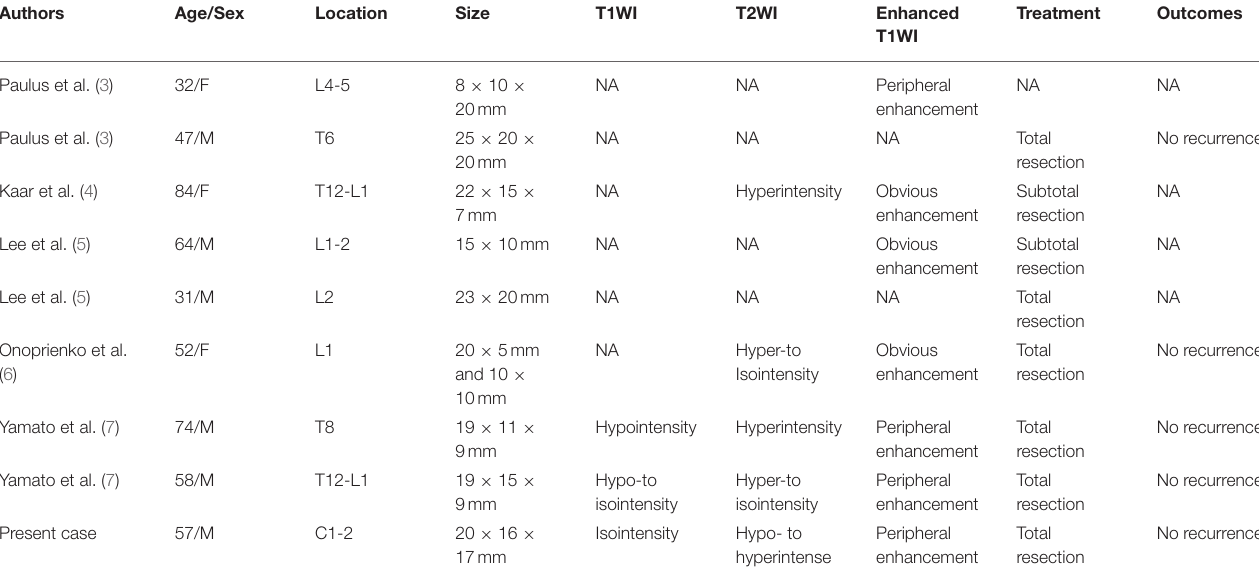
TABLE 1 | Summary of previously reported cases of intraspinal nerve sheath myxoma.